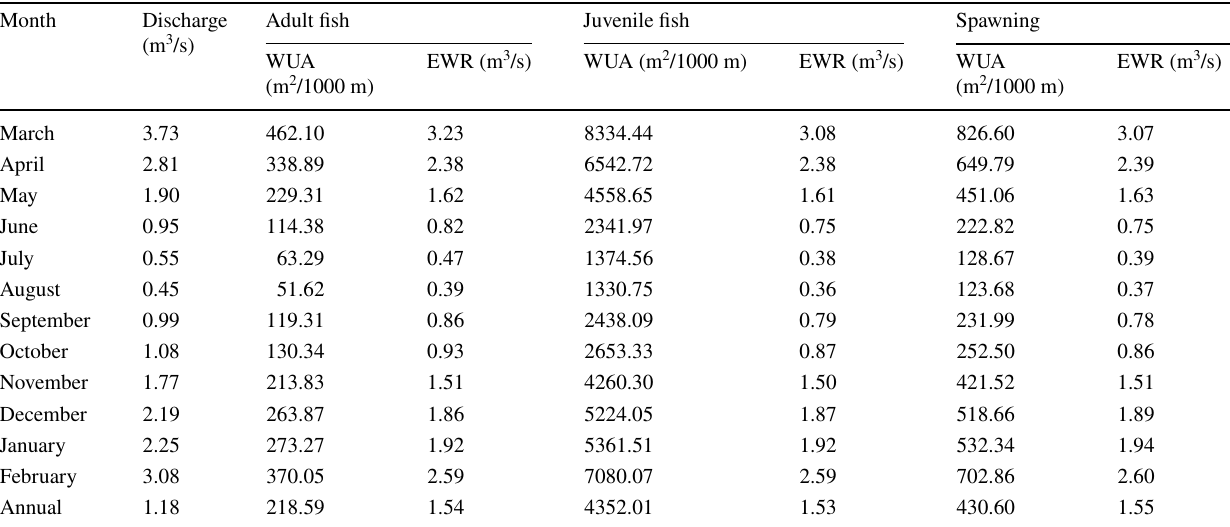
Table 1 EWR of the Qarasu river for the Rutilus frisii kutum during three stages of adult fish, juvenile fish, and spawning Month Discharge Adult fish Juvenile fish (m 3 /s)